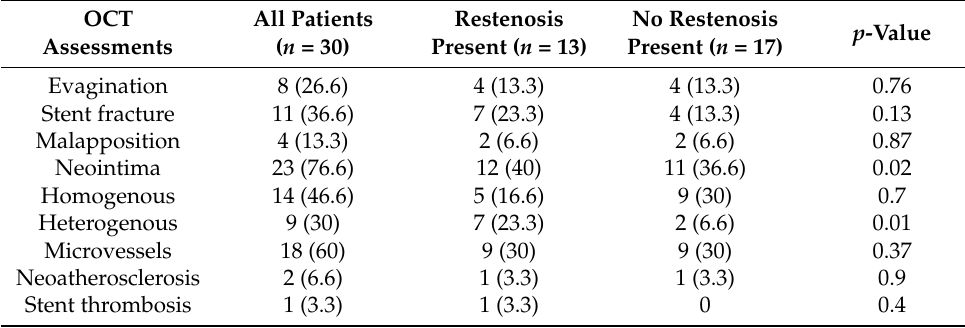
Table 4. Qualitative OCT assessment at